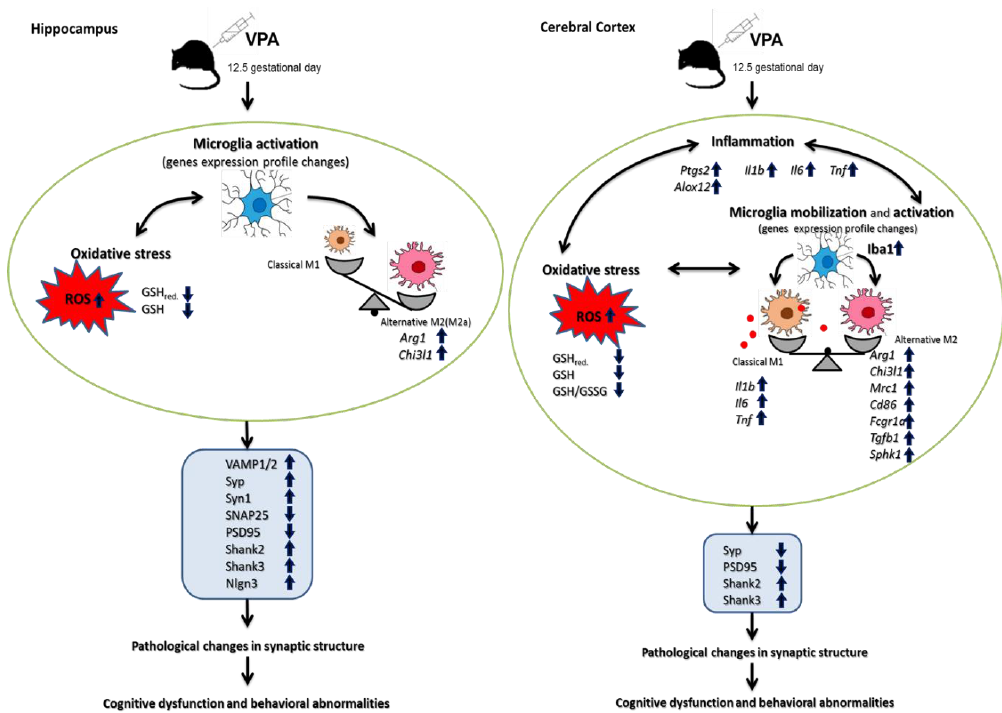
Figure 12. Schematic diagram showing the effect of prenatal exposure to VPA on the pathological changes in brains of young-adult male offspring. A single i.p . injection of VPA at 12.5 days of pregnancy-induced brain structure-specific defects in the expression of key pre- and postsynaptic proteins, consequently leading to pathological alterations in the structure of the synaptic endings (the hippocampus and cerebral cortex). In the hippocampus, the importance of oxidative stress and ROS generation in synaptic pathology is suggested. In the cerebral cortex, in addition to oxidative stress and ROS generation, neuroinflammation associated with microglia mobilization and M1 activation have also been proposed as potential triggers of a molecular cascade leading to synaptopathology. VPA induced long-lasting changes in microglia status in a brain structure-specific manner. In the cerebral cortex, both the pro-inflammatory M1 and the potentially beneficial recovery-promoting M2 phenotype were activated, while in the hippocampus, only M2 was